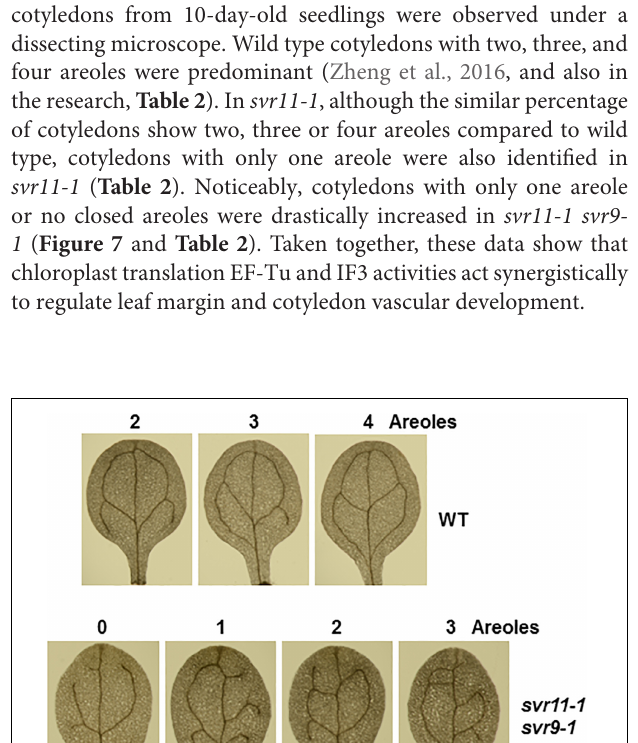
the functional relationships between SVR11 and SVR9 , as well as SVR9L1 , a functionally redundant homolog of SVR9 ( Figure 6 ) (Zheng et al., 2016). At the single mutant level, svr9-1 showed a stronger degree of virescence than that of svr11-1 , and svr9l1-1 showed a WT-like phenotype, as reported ( Figure 6A ) (Zheng et al., 2016). Consistent with both EF-Tu and IF3’s involvement in translation, svr11-1 svr9- 1 mutants were more virescent ( Figure 6 ). The virescent level of svr11-1 , svr9-1 and svr11-1 svr9-1 double mutants were